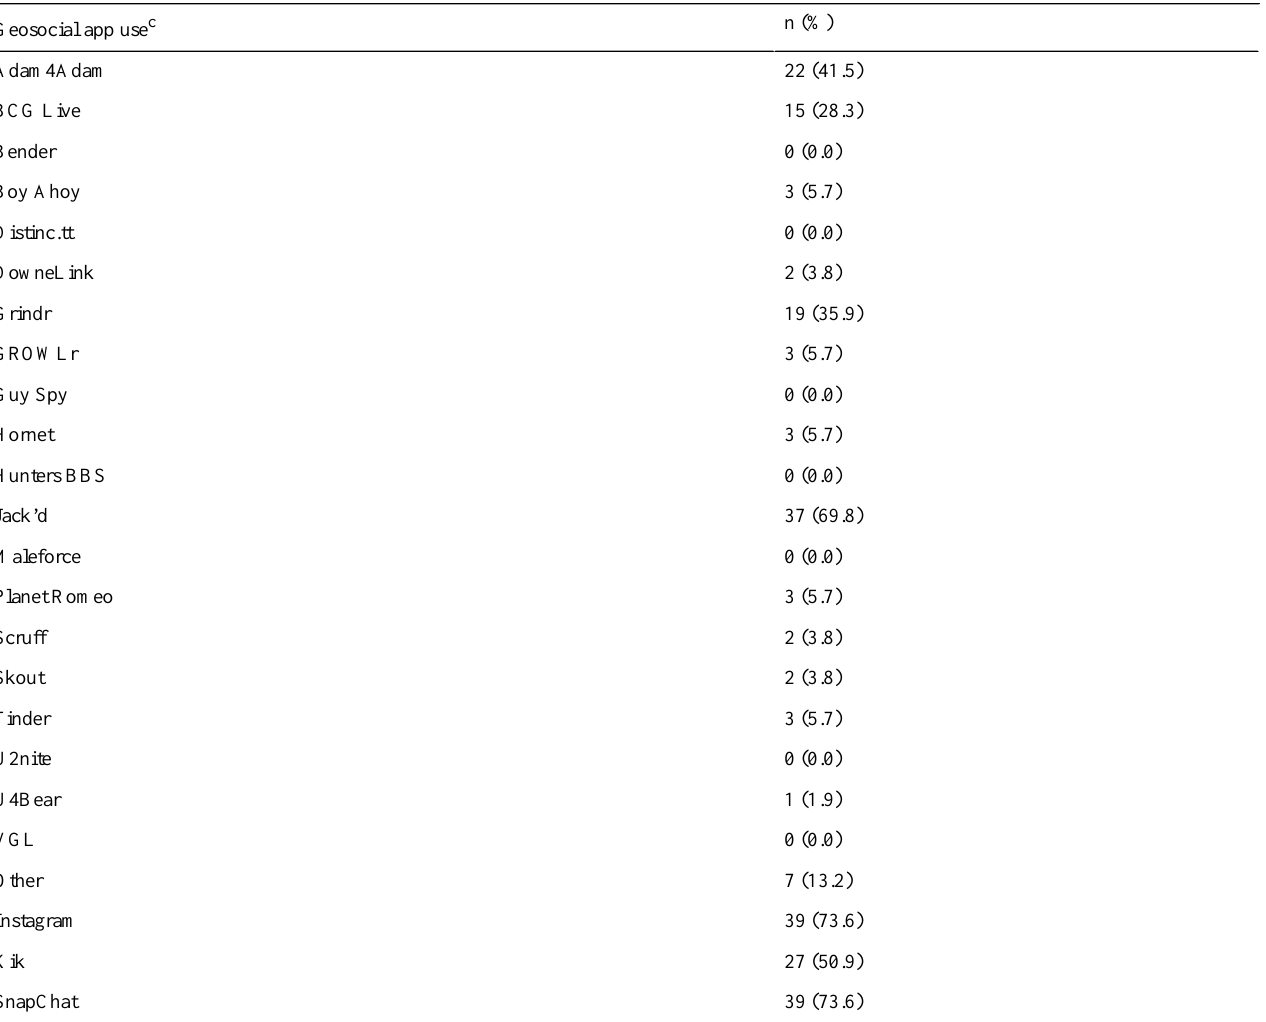
Table 2. Geosocial networking app use a among MSM (N=53 b